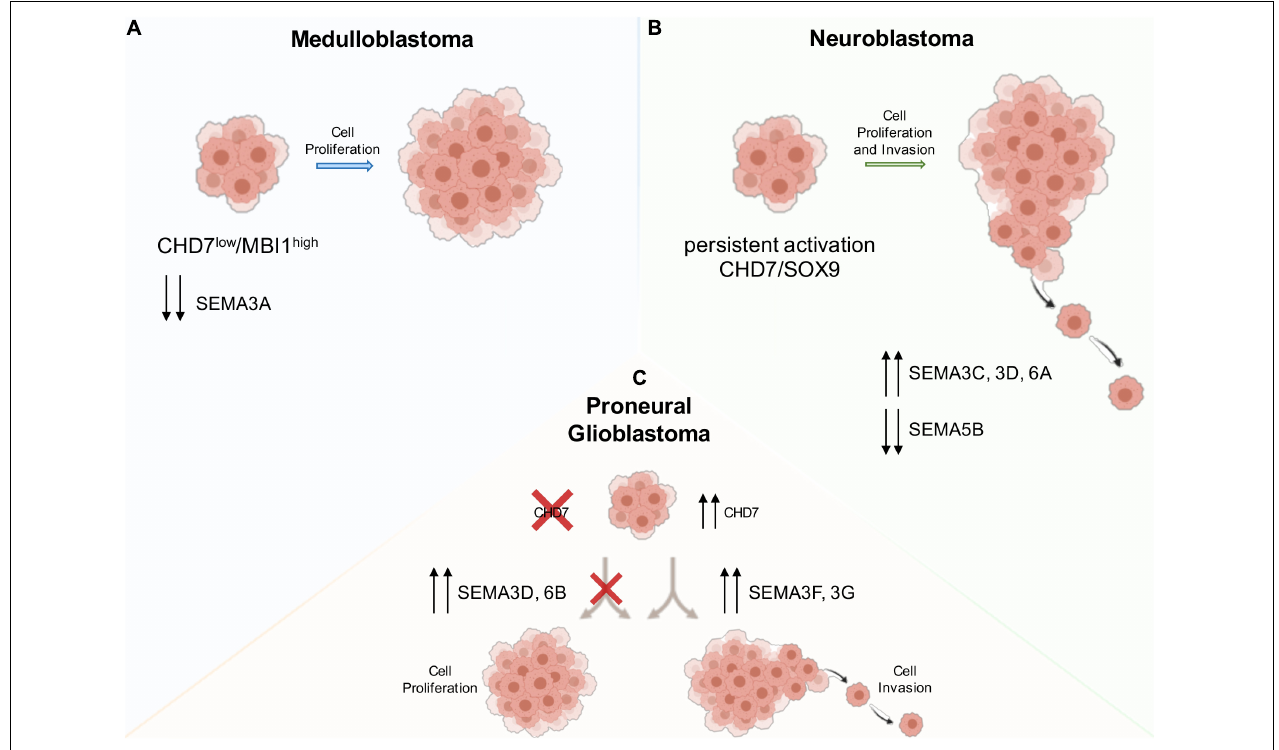
FIGURE 3 | Schematic drawing showing the interaction between CHD7 and semaphorins in the indicated forms of tumors and its effects on tumor growth and invasiveness. (A) In medulloblastoma cells, a low expression of CHD7 and the subsequent downregulation of SEMA3A lead to increased cancer cell proliferation and higher tumor growth rate. (B) Neuroblastoma cells display increased proliferation and invasion due to a persistent activation of CHD7/SOX9 signaling, causing increased levels of NC-related genes, and decreased levels of neuronal differentiation genes. (C) Growth rate and invasion are affected in proneural glioblastoma cells by either CHD7 deletion or overexpression, which upregulate class 3 semaphorin downstream genes. Red crosses indicate a lack of the gene or impairment of the indicated biological process; the up and down arrows indicate expression changes of the indicated